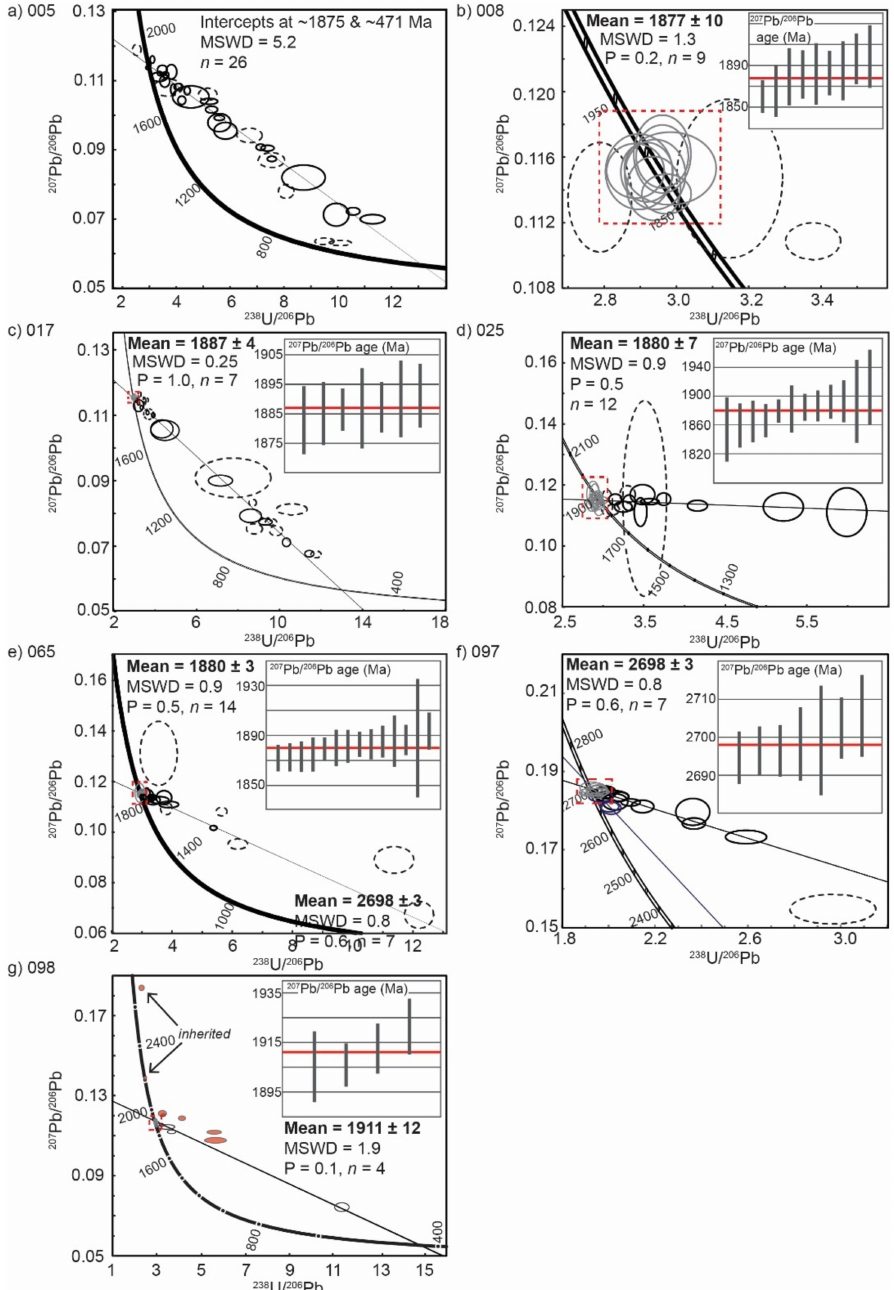
Figure 8. SIMS data in Tera–Wasserburg diagrams and 207 Pb/ 206 Pb weighted average plots for the samples: ( a ) 005; ( b ) 008; ( c ) 017; ( d ) 025; ( e ) 065; ( f ) 097; and ( g ) 098. Dashed black and red-filled circles represent data points left out of regression calculations. Gray circles represent data used for 207 Pb/ 206 Pb weighted average ages. Data point error ellipses and error bars are 2 σ . The weighted average age is taken as the most reliable estimate of the crystallization age of the